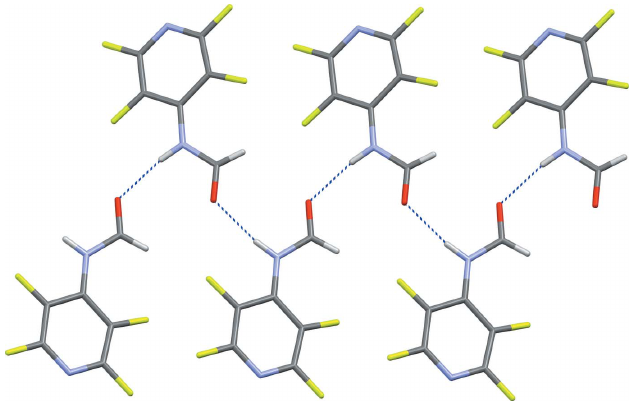
Figure 3 Extended structure as viewed looking down the b -axis showing the L- shape that is formed by the orthogonal pyridine rings of neighboring chains.